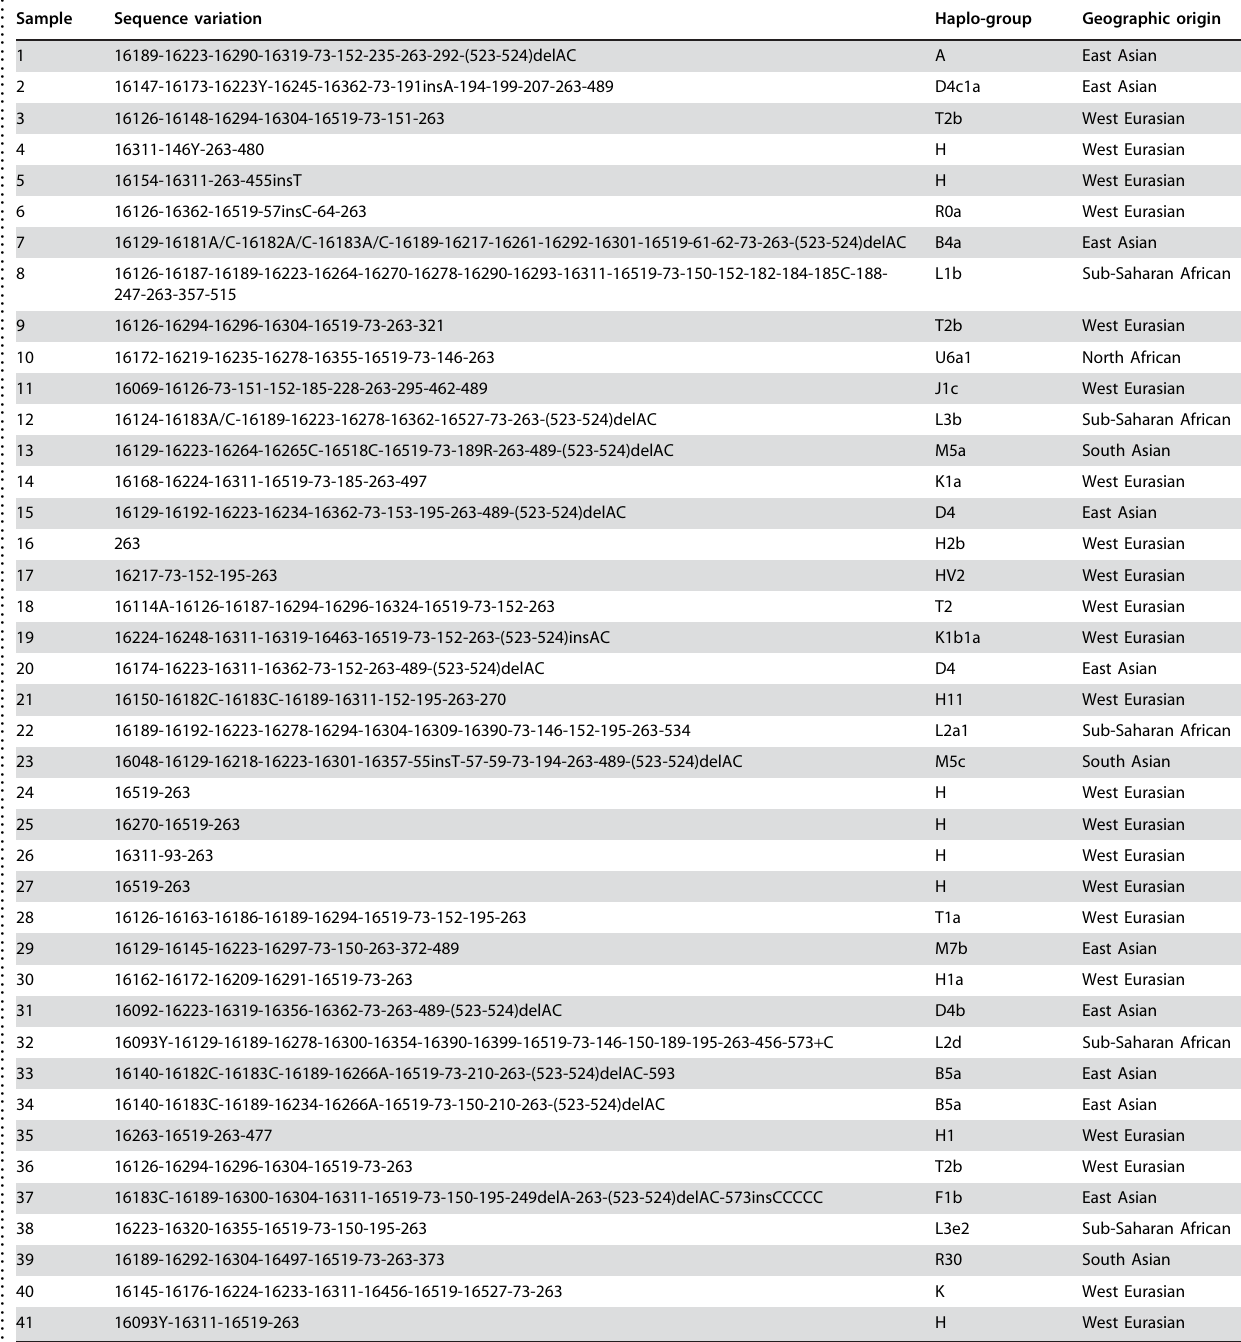
Table 1. MtDNA sequence variation and haplogroup status in current and past laboratory personnel. .. ... .... ... ... .... ... ... .... ... ... .... ... ... .... ... ... .... ... ... .... ... ... .... ... ... .... ... ... .... ... ... .... ... ... .... ... ... .... ... ... .... ... ... .